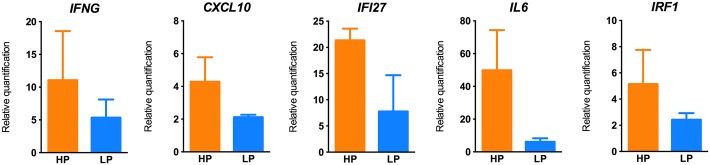
qRT-PCR validation of genes commonly modulated in High- and Low- IFN-γ producers.PBMCs from High Producers (HPs) (n = 3) and Low Producers (LPs) (n = 3) were stimulated with L. braziliensis for 72h. Relative expression of IFNG, CXCL10, IFI27, IL6 and IRF1 was evaluated by qRT-PCR. Gene expression is represented as fold change of stimulated over unstimulated cultures, normalized to a housekeeping gene. Bars represent the mean ± SEM.